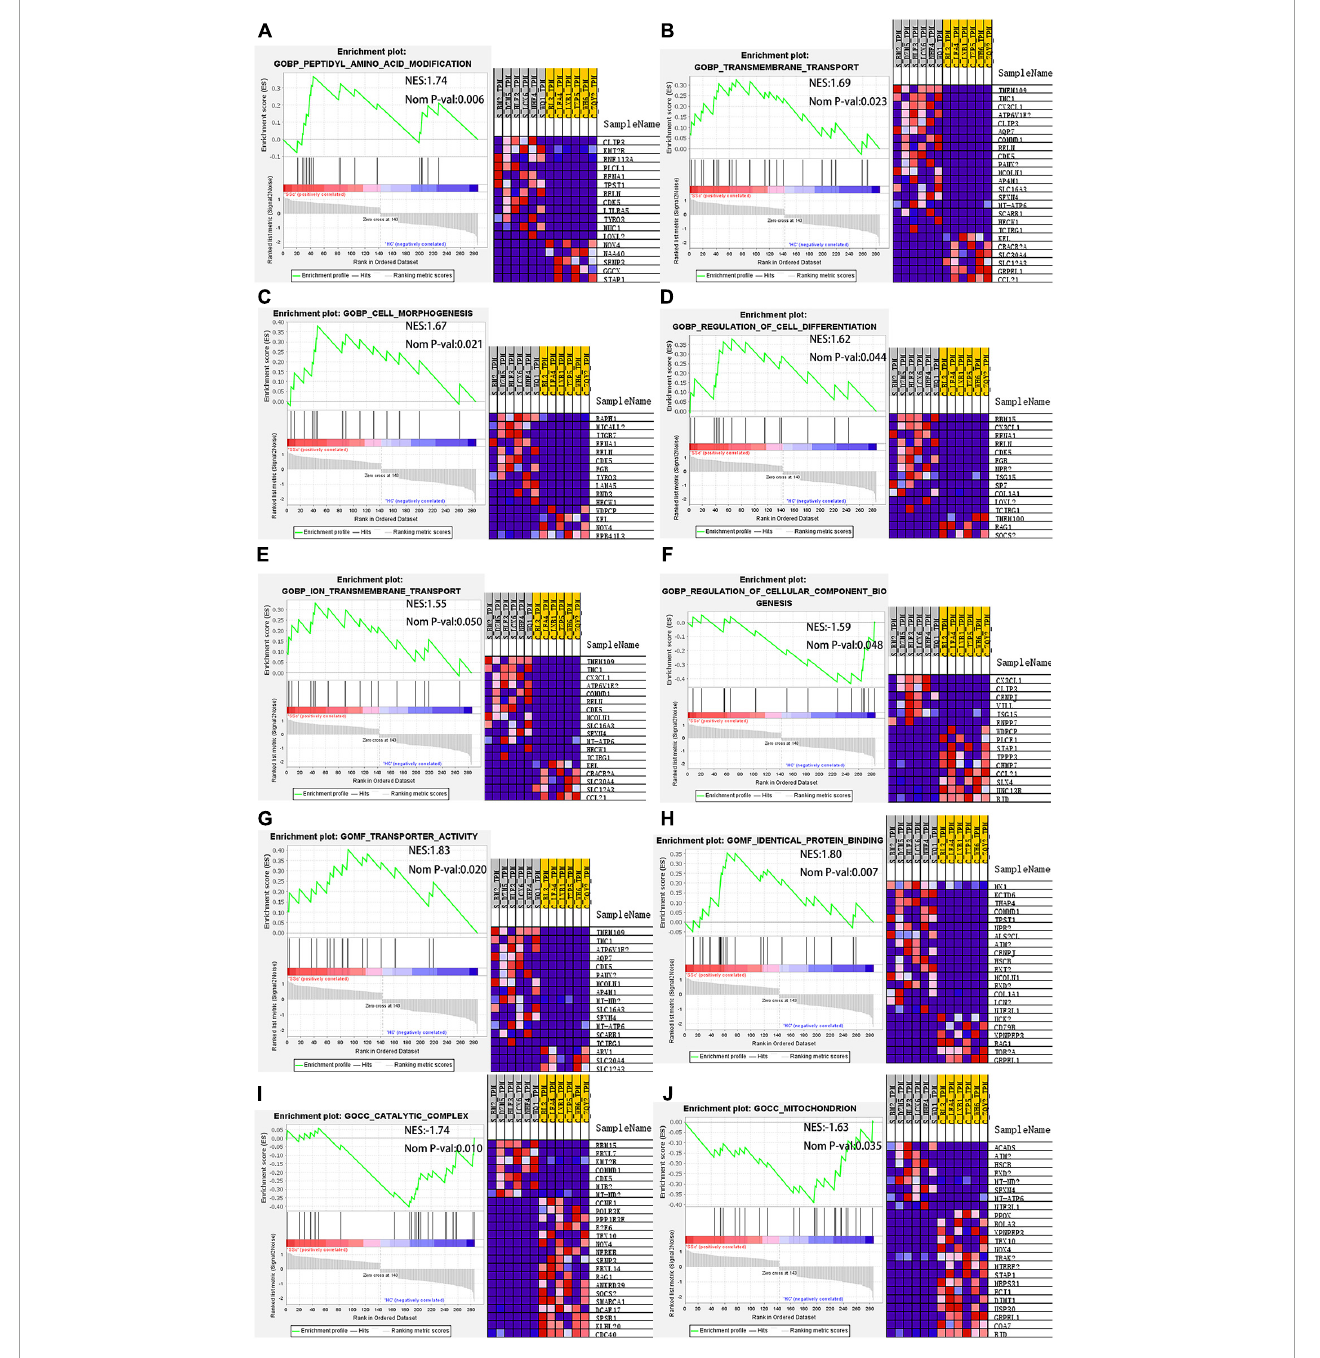
FIGURE8 GSEA. In BP, the gene sets with significantly enriched upregulated genes include (A) peptidyl amino acid modification, (B) transmembrane transport, (C) cell morphogenesis, (D) regulation of cell differentiation, and (E) ion transmembrane transport. The gene set with significantly enriched downregulated genes includes (F) regulation of cellular component biogenesis. In MF, the gene sets with significantly enriched upregulated genes include (G) transporter activity and (H) identical protein binding. In CC, the gene sets with significant enrichment of downregulated genes include (I) catalytic complex mitochondrion and (J) mitochondrion. GSEA, gene set enrichment analysis; BP, biological process; MF, molecular function; CC, cell component.